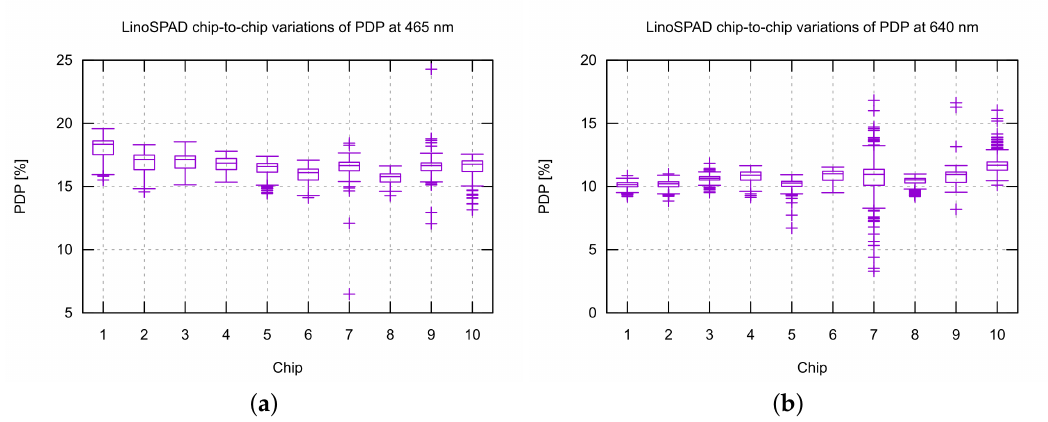
Figure 16. Chip-to-chip PDP variations at: 465 nm ( a ); and 640 nm ( b ) for uniform excess bias of 2 V. The variations are quite small, bearing evidence of a mature, well-controlled fabrication